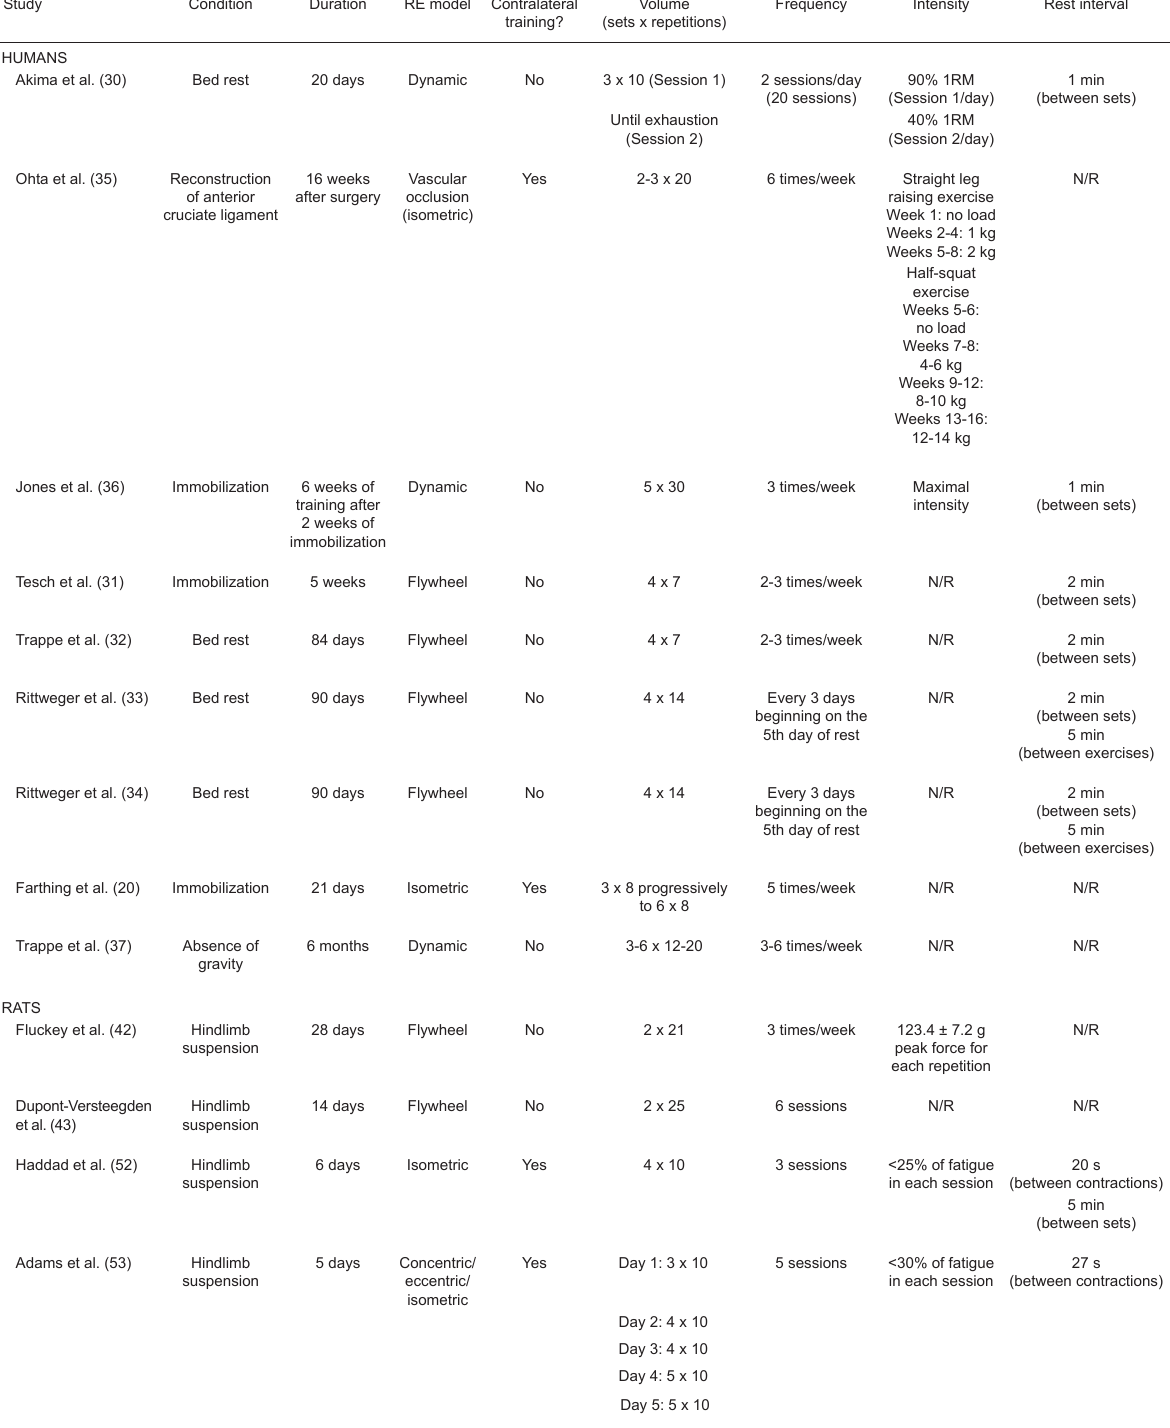
Volume Frequency Intensity Rest interval training? (sets x repetitions)